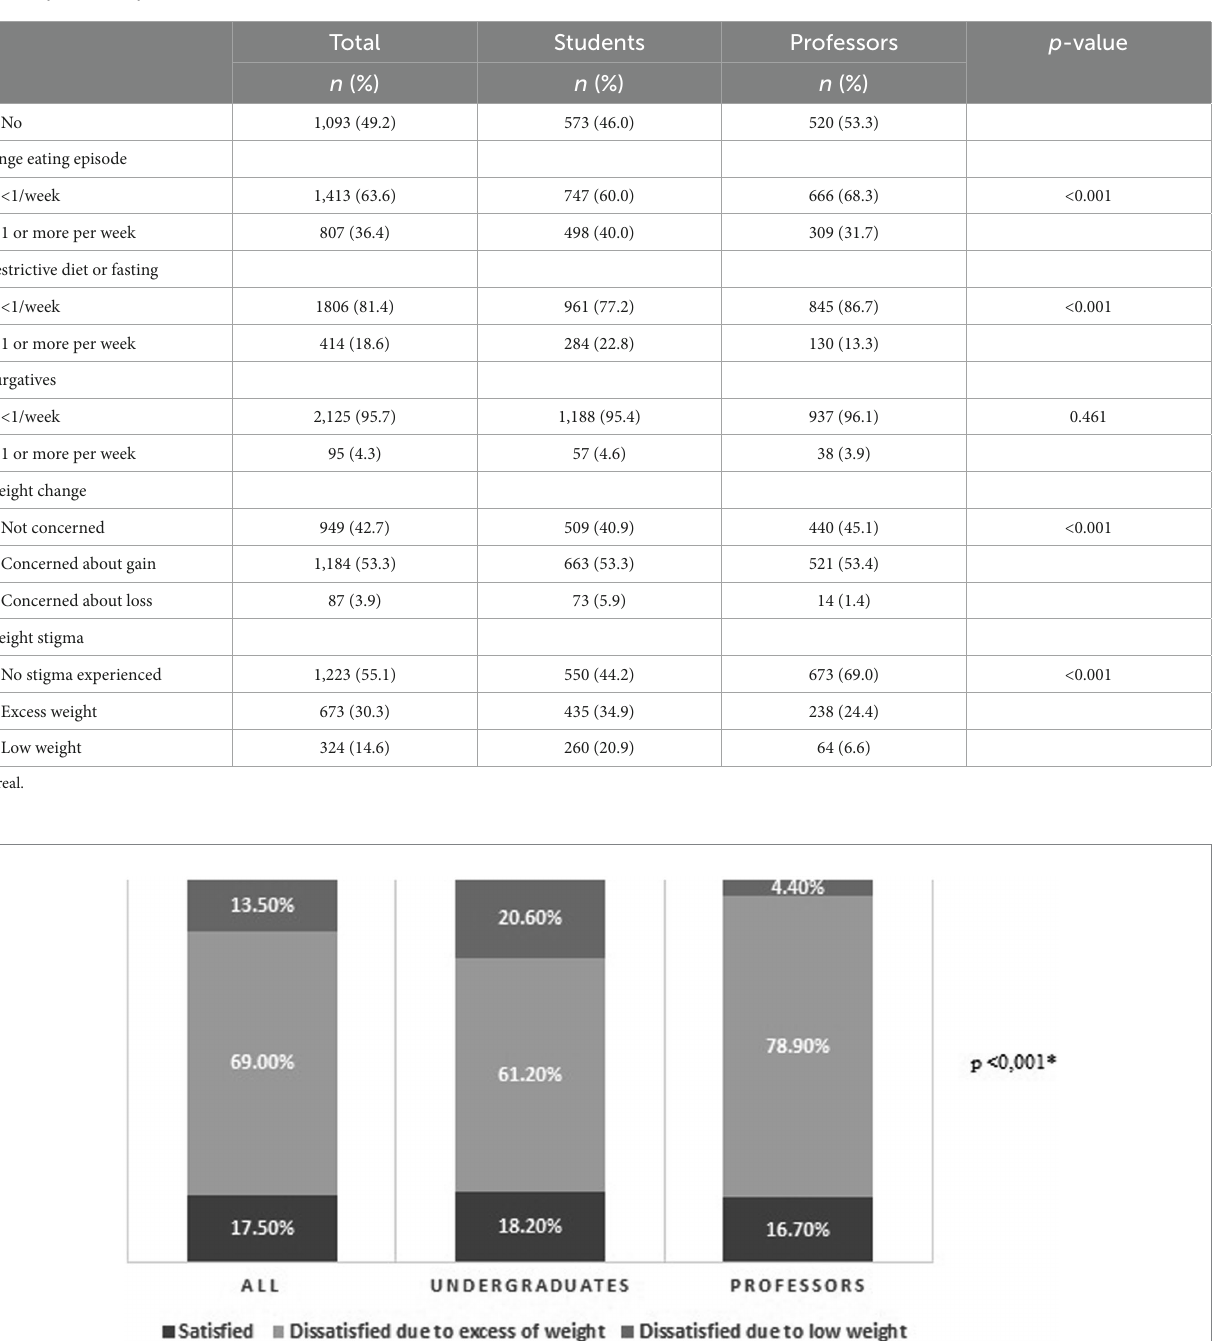
FIGURE 1 Prevalence of body image satisfaction and dissatisfaction in undergraduates and professors at Brazilian universities. *Chi-squared